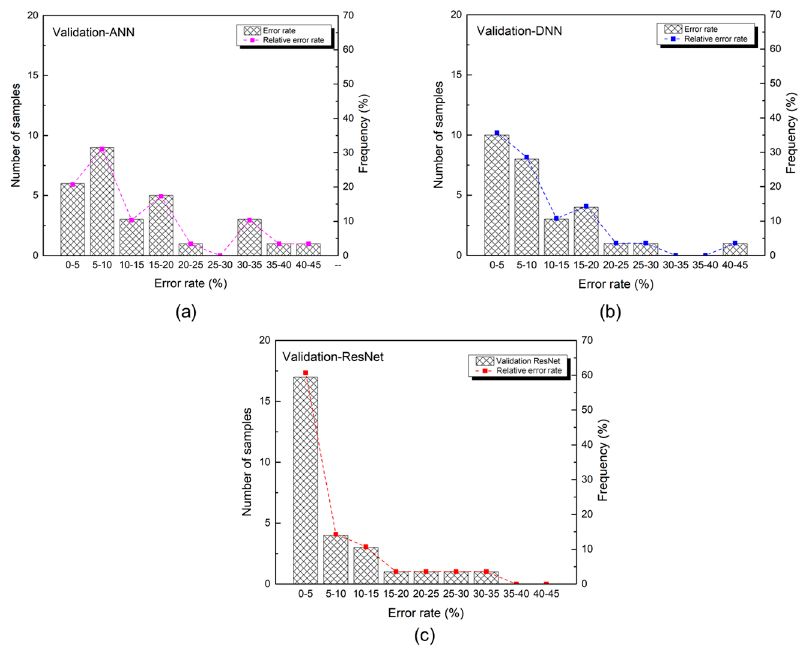
Figure 9. Error rate distribution of three proposed approaches: ( a ) validation ANN; ( b ) validation DNN; ( c ) validation ResNet.